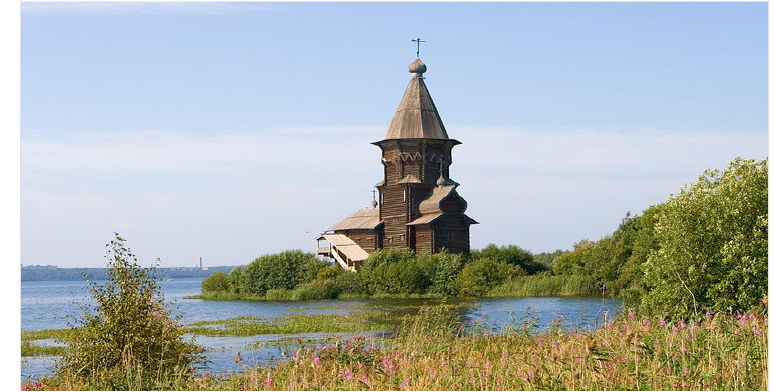
Fig. 2. Church of the Assumption of the Blessed Virgin in Kondopoga (Photo: Sergey Sverdlov from Wikimedia